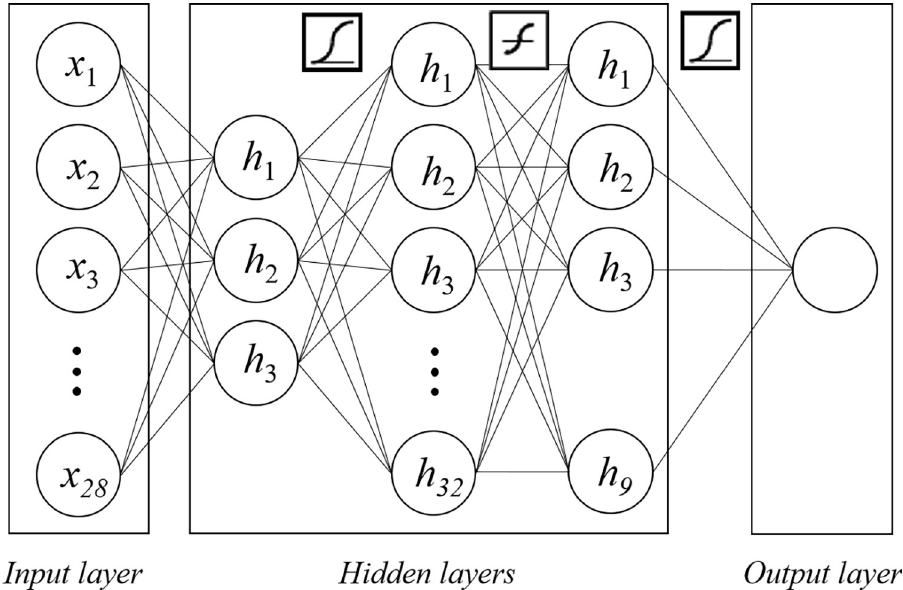
Fig 4. Our proposed artificial neural network model consisted of a 28-item input layer and 3 hidden layers with 3, 32, and 9 nodes, respectively. The activation functions defined the log-sigmoid transfer function between hidden layers 1 and 2, the hyperbolic tangent function between hidden layers 2 and 3, and the log-sigmoid transfer function between hidden layer 3 and the output layer.